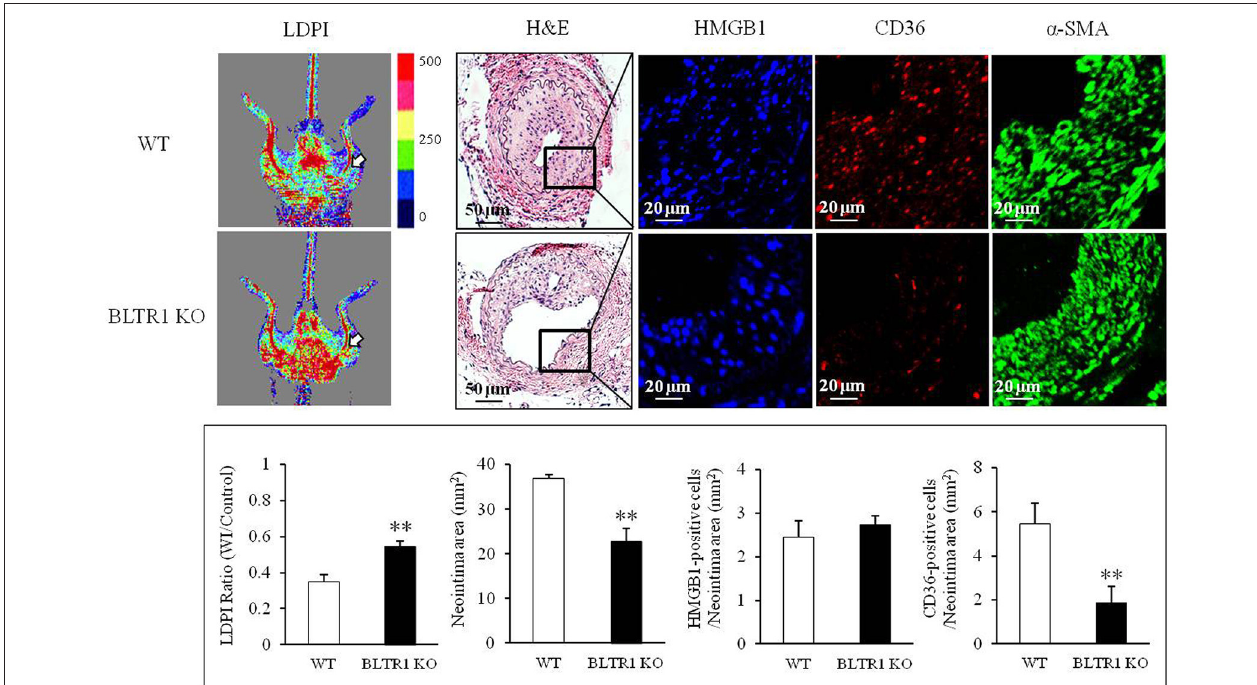
FIGURE 5 | Involvement of BLTR1 in macrophage infiltration and neointima formation in wire-injured femoral arteries. Doppler images: Blood flow in the femoral arteries of WT and BLTR1-deficient (KO) mice at 4 wks after wire injury (WI) was assessed using a LDPI analyzer. In these color-coded images, red hue indicates regions of maximum perfusion, medium perfusion values are shown in yellow, and lowest perfusion values are represented as blue. Arrows indicate blood flow in an injured femoral artery. Photographs are representative of 5-6 independent experiments. H&E: Cross sections of mouse femoral arteries were prepared at 4 wks after WI, and stained with H&E. HMGB1 and CD36: HMGB1 and macrophage infiltration in the indicated neointima were stained with anti-HMGB1 antibody and anti-CD36 antibody, respectively. α -SMA: VSMCs were stained with anti- α -SMA antibody. Images are representative of 5–6 independent experiments. Bottom: LDPI ratio was quantified as the ratio of the blue-to-red pixels in the injured artery (WI) vs. non-injured arteries (Control). Neointima volumes in the cross sections of injured femoral artery were determined using an image analyzer. Numbers of HMGB1-positive and CD36-positive cells in neointima area were quantified, and data were presented as the means ± SEMs of 3-4 independent experiments. ** P < 0.01 vs. WT